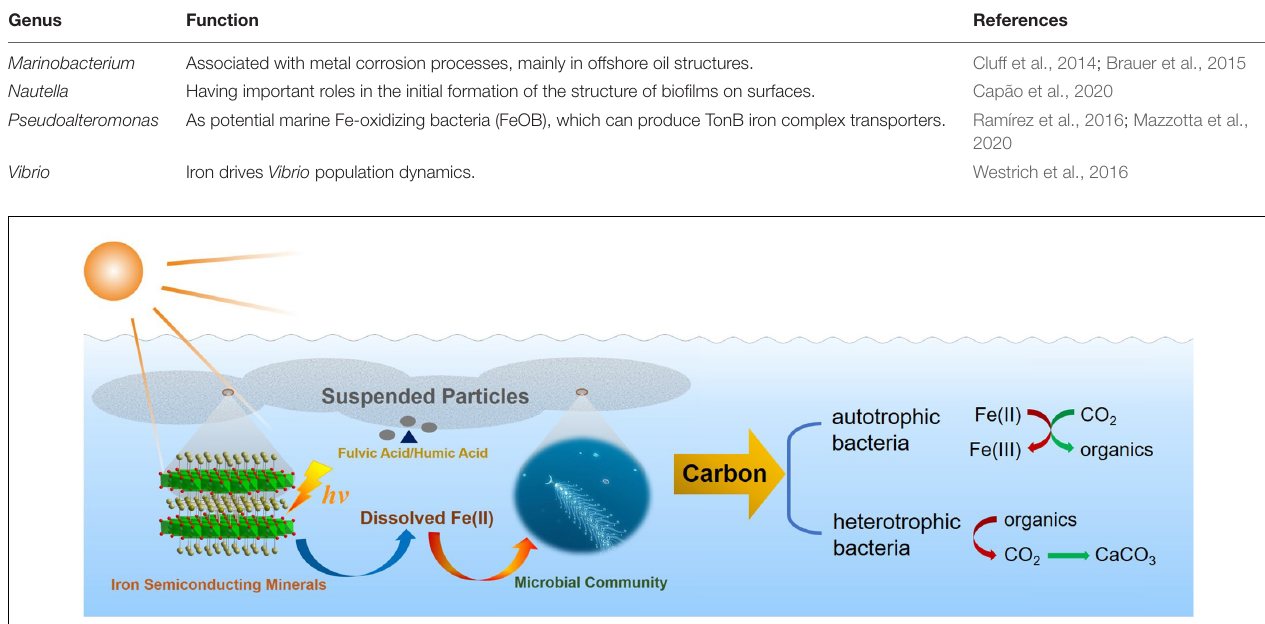
FIGURE 11 | The diagram of effect and regulation of dissolved Fe(II) on microbial community and driving carbon cycle in the marine euphotic